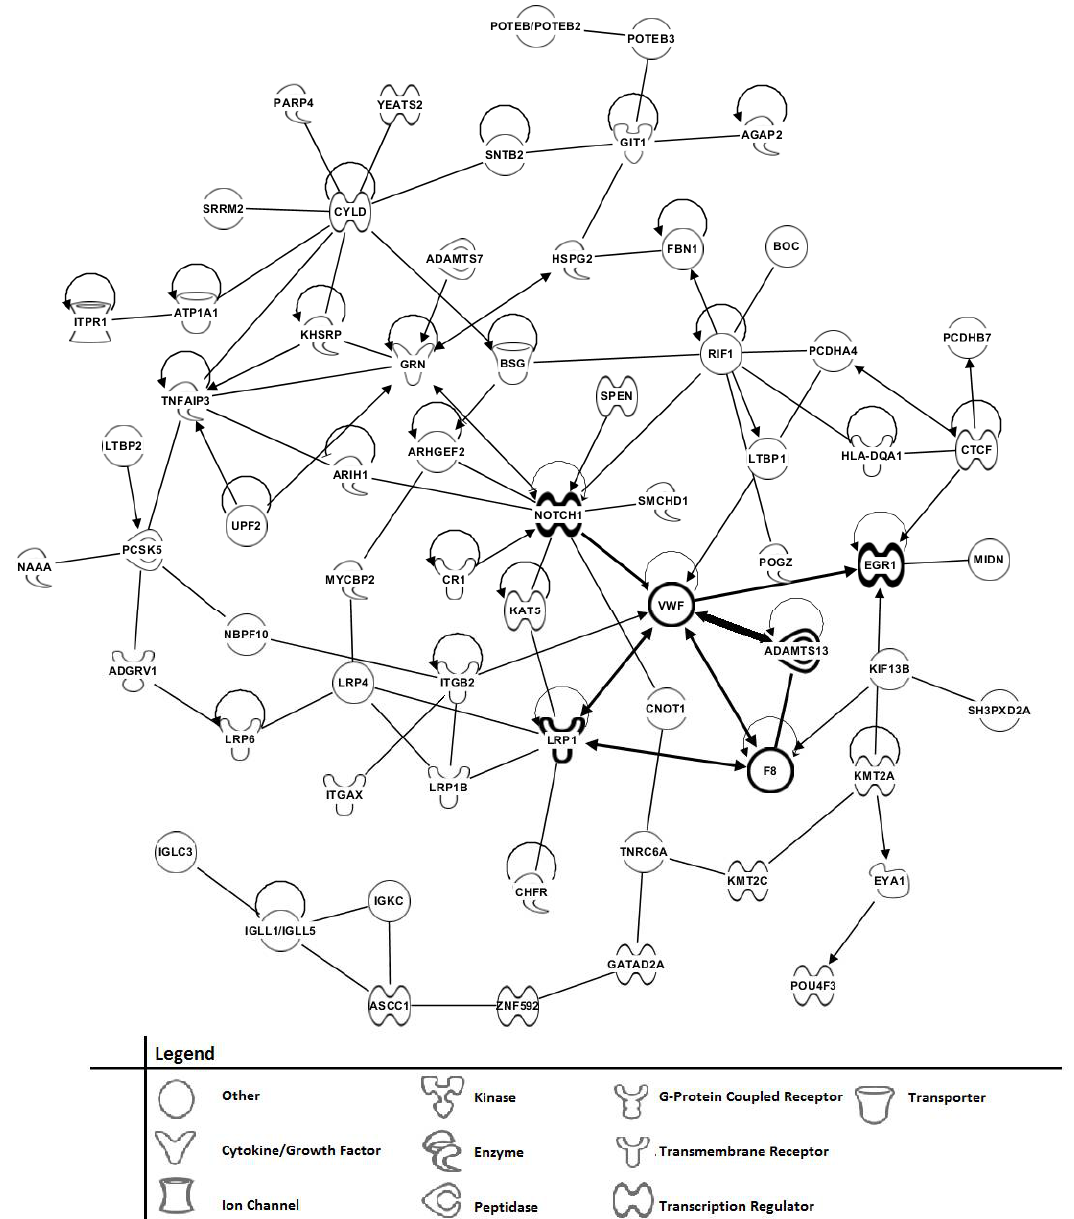
Figure 6. Potential protein IPA connections (no functional considerations) in mild Alzheimer’s disease as determined by serum tandem MS/MS peptide/protein analysis. Arrows indicate a direct scientific literature connection and lines indicate indirect literature connections. The bolded arrow indicates the VWF/ADAMTS13 protein (proteins in bold) axis, and the darkened arrows indicate other potential protein connections to this axis (protein names in bold). The protein function symbol legend is at the bottom of the figure.